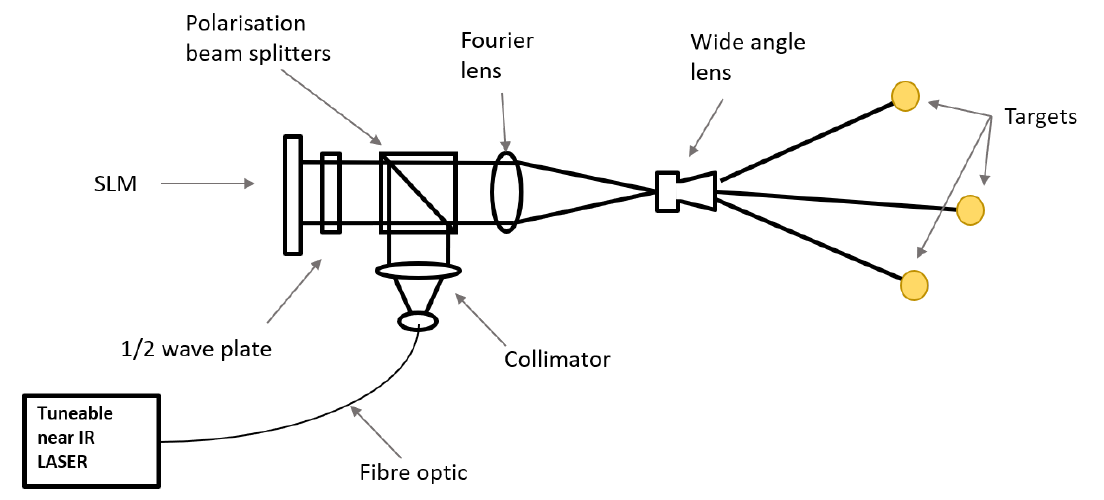
Figure 2. SLM projection optics of the OPTIMUM system